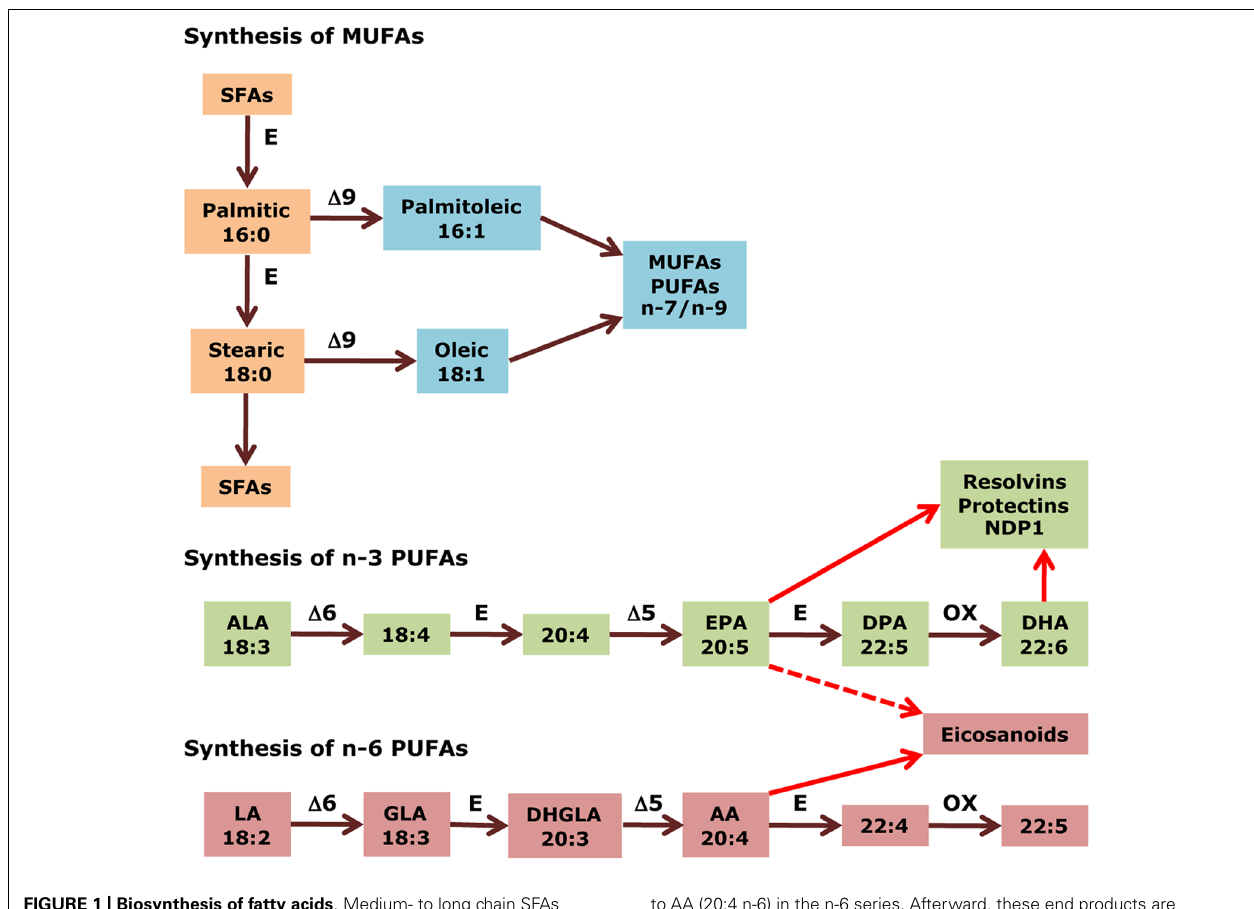
to AA (20:4 n-6) in the n-6 series. Afterward, these end products are further elongated, desaturated, and submitted to peroxisomal β - oxidation (all three steps indicated by OX) to yield DHA (22:6 n-3) and docosapentaenoic acid (22:5 n-6), respectively. Finally, AA (20:4 n-6) is the precursor of potent pro-inflammatory eicosanoids. EPA (20:5 n-3) produces less potent (dashed arrow) eicosanoids and, together with DHA (22:6 n-3), gives rise to docosanoids with anti-inflammatory properties (i.e., resolvins and protectins). GLA, γ -linolenic acid; DHGLA, dihomo- γ -linolenic